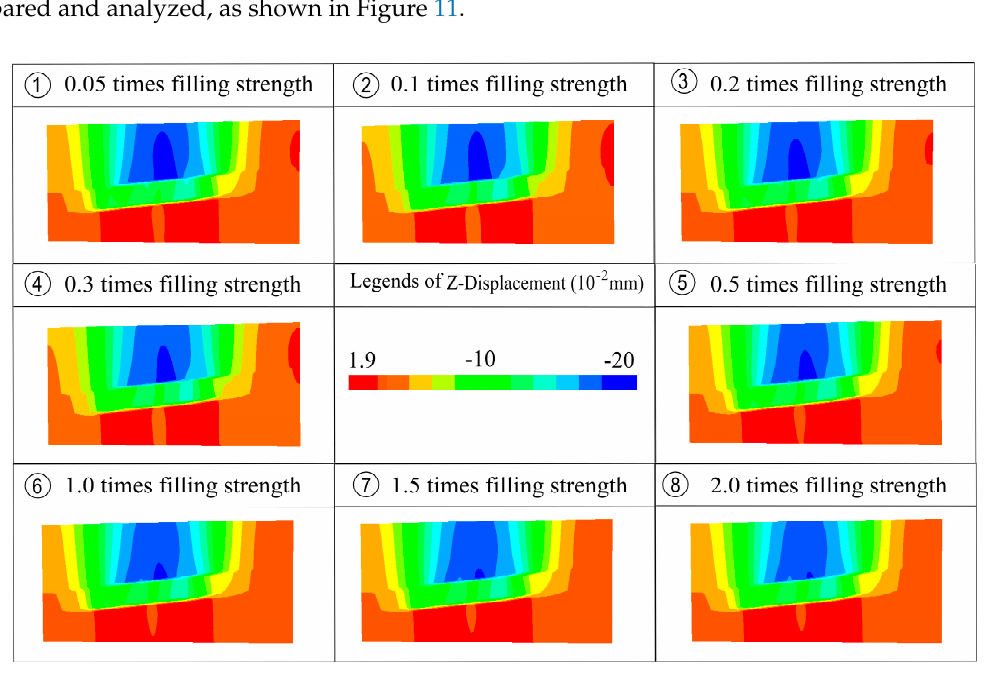
Figure 11. Cloud map of displacement with different strengths of backfilling materials (BMSs).